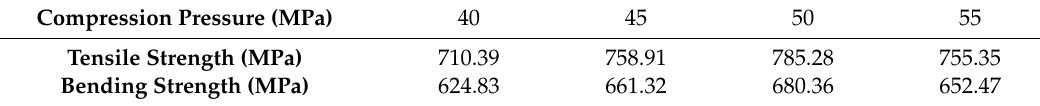
Table 9. Effects of compression pressure on mechanical performance. Table 9. E ff ects of compression pressure on mechanical